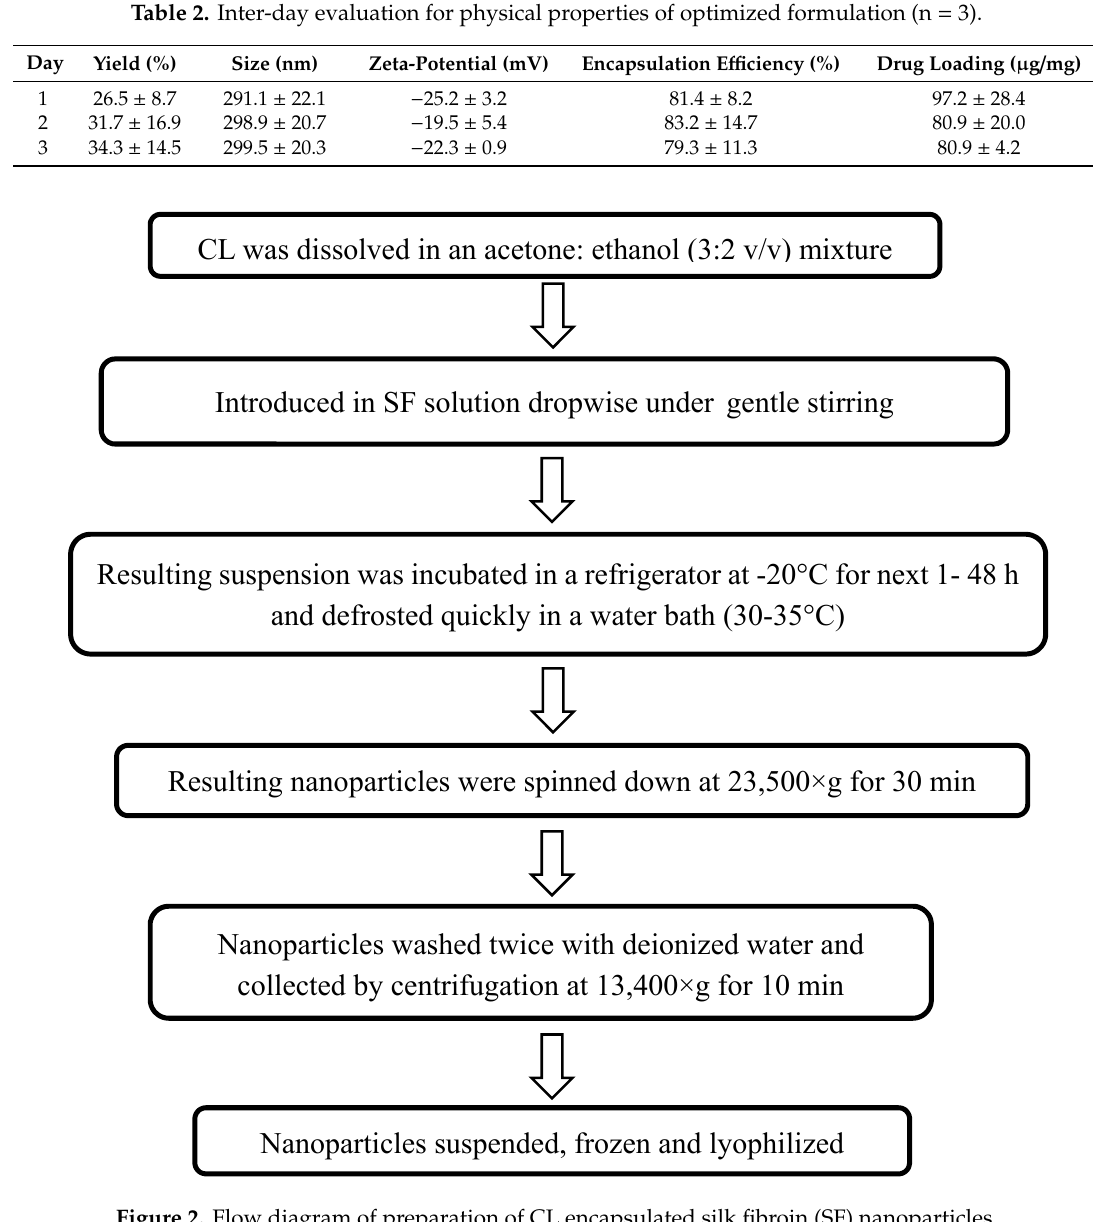
Figure 2. Flow diagram of preparation of CL encapsulated silk fibroin (SF) nanoparticles.